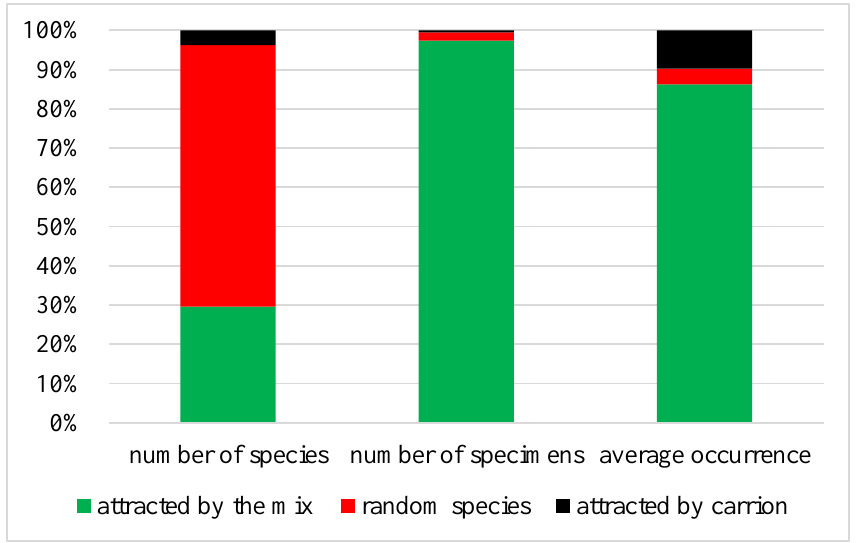
Figure 2. The ratio of the number of species, the number of specimens and the average occurrence of species, depending on the ability to attract to the bait.